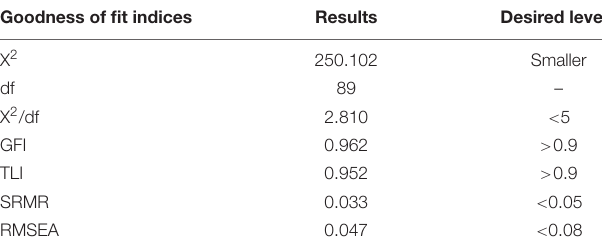
TABLE 5 | Goodness of fit indices for the structural